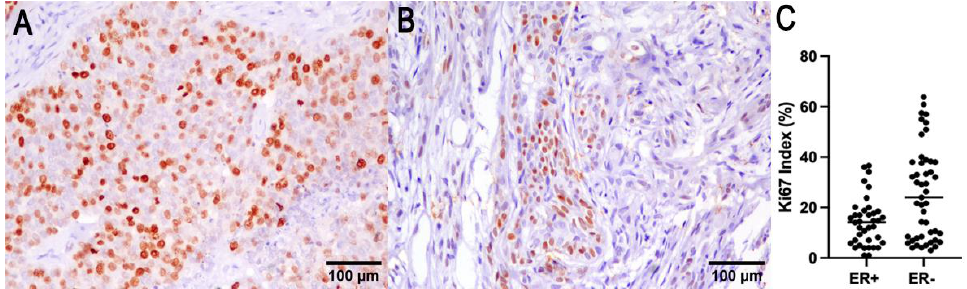
Figure 3 . Ki67 ( A ) and ER ( B ) immunohistochemistry of a representative CMC. ( C ) ER expression was found to be correlated with a lower Ki67 index.